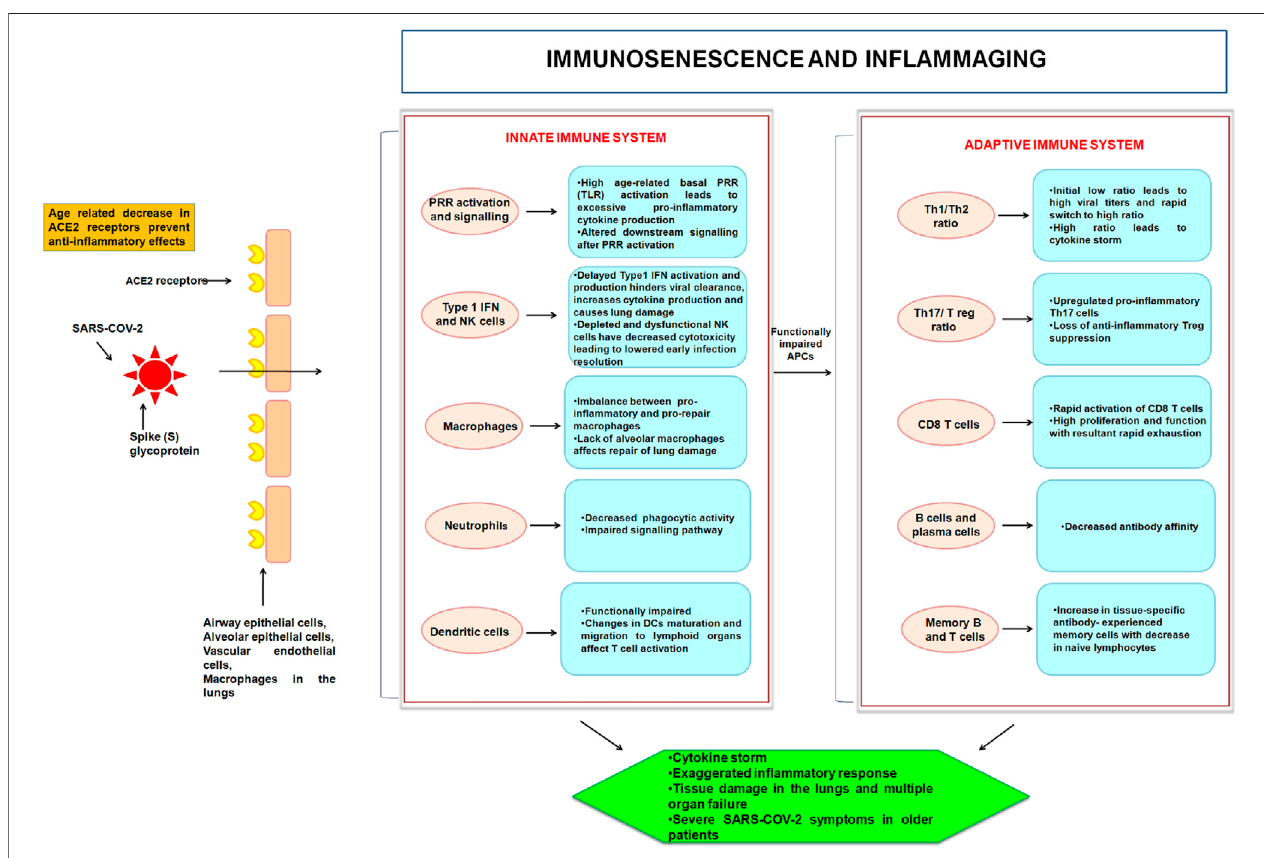
FIGURE 1 | Age-linked modi fi cations in the innate and adaptive immune systems with relevance to COVID-19 are depicted in this illustration. SARS-CoV-2 mediated in fl iction of parenchymal cells (through ACE2 receptor) ensues in activation of PRR of the innate immune system of the host. With age, cellular activities and signaling become deranged. This hampers the innate activation of an already diminished adaptive immune system. The abnormalities result in “ in fl ammaging ” from proin fl ammatory innate immune responses and adaptive immunological immunosenescence.